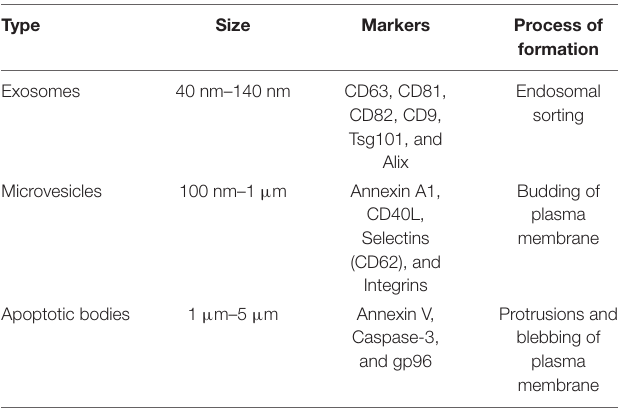
TABLE 1 | Characteristics of extracellular vesicles